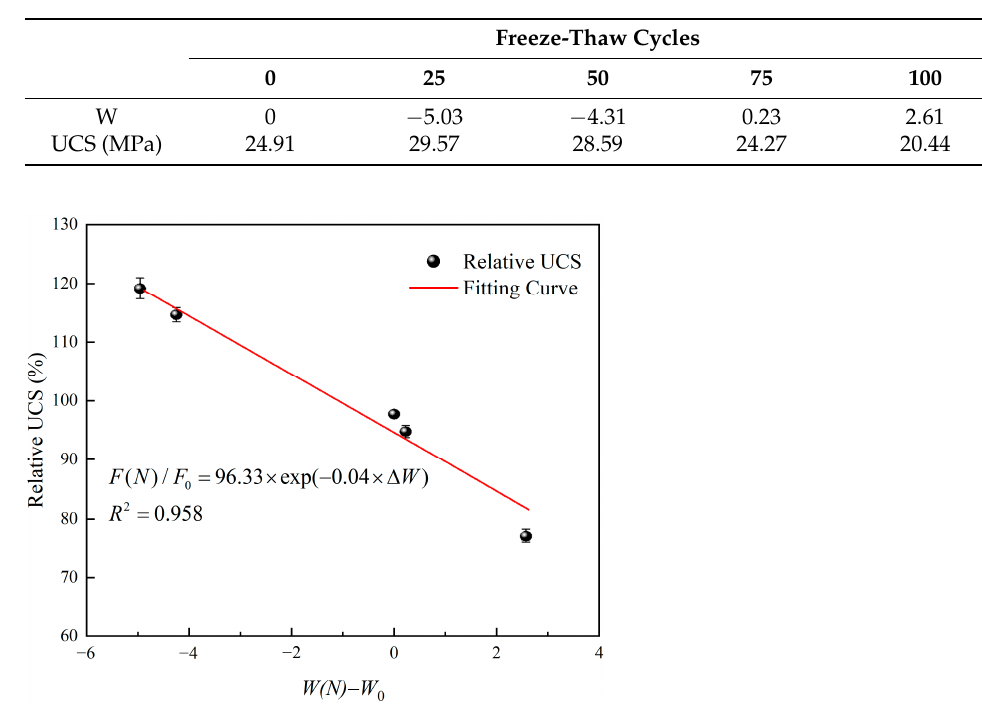
Figure 10. The relationship between relative UCS and the change amount of the freeze-thaw fac- tor.